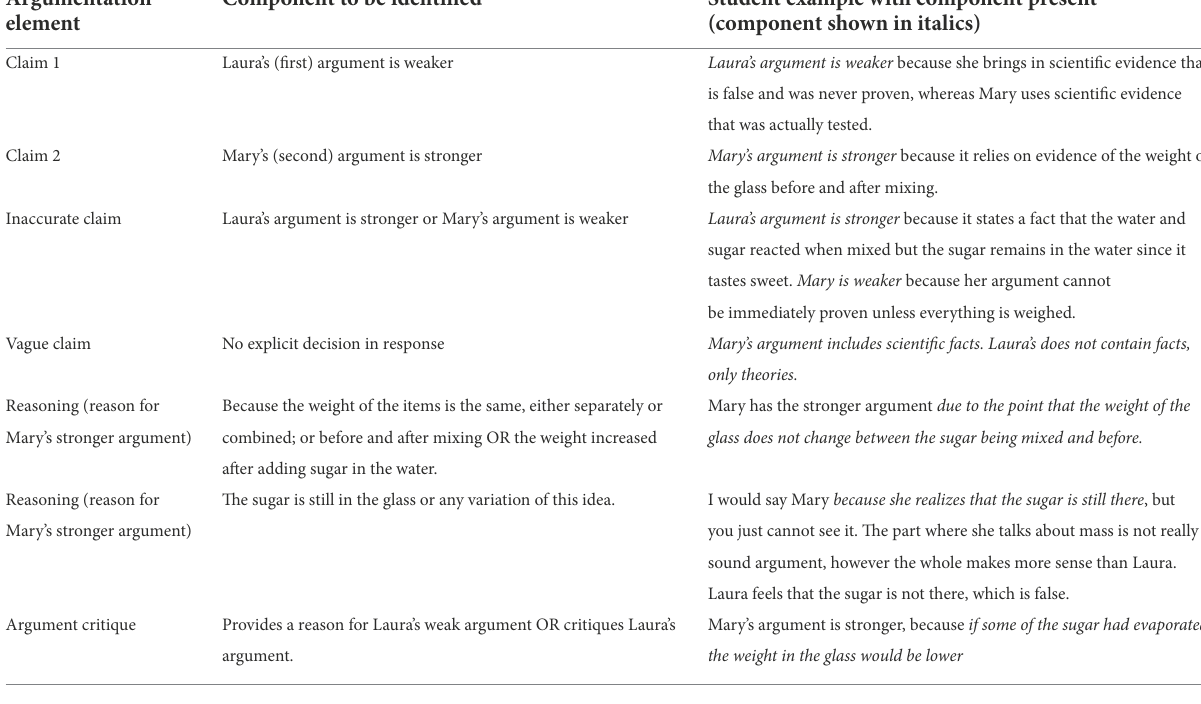
TABLE 2 Coding rubric for item sugar 5.